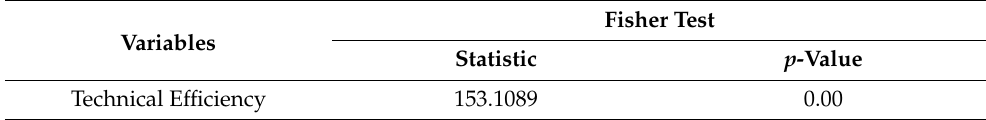
Table 6. Results of the unit root test.